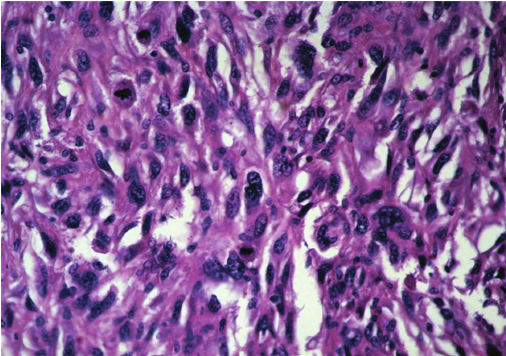
Figure 1: Highly atypical spindle cells arranged in fascicles, and presenting brisk mitotic activity (H&E, × 400).